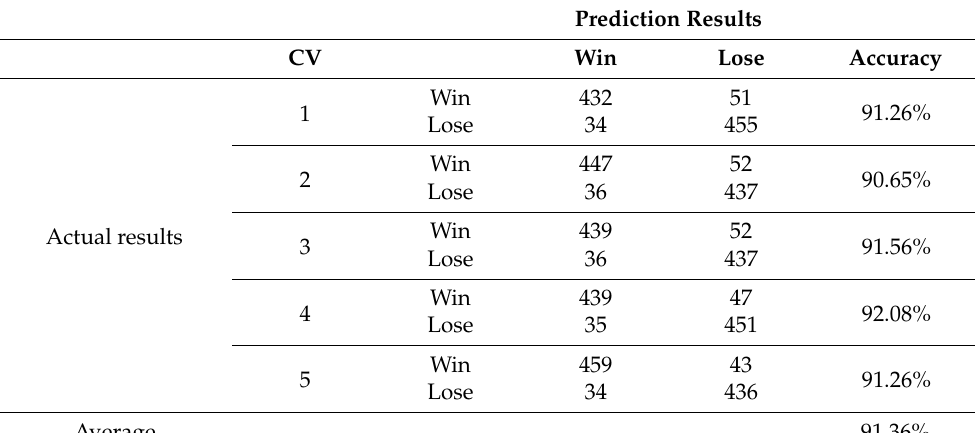
Table 8. Confusion matrix of SVM without feature selection (dataset